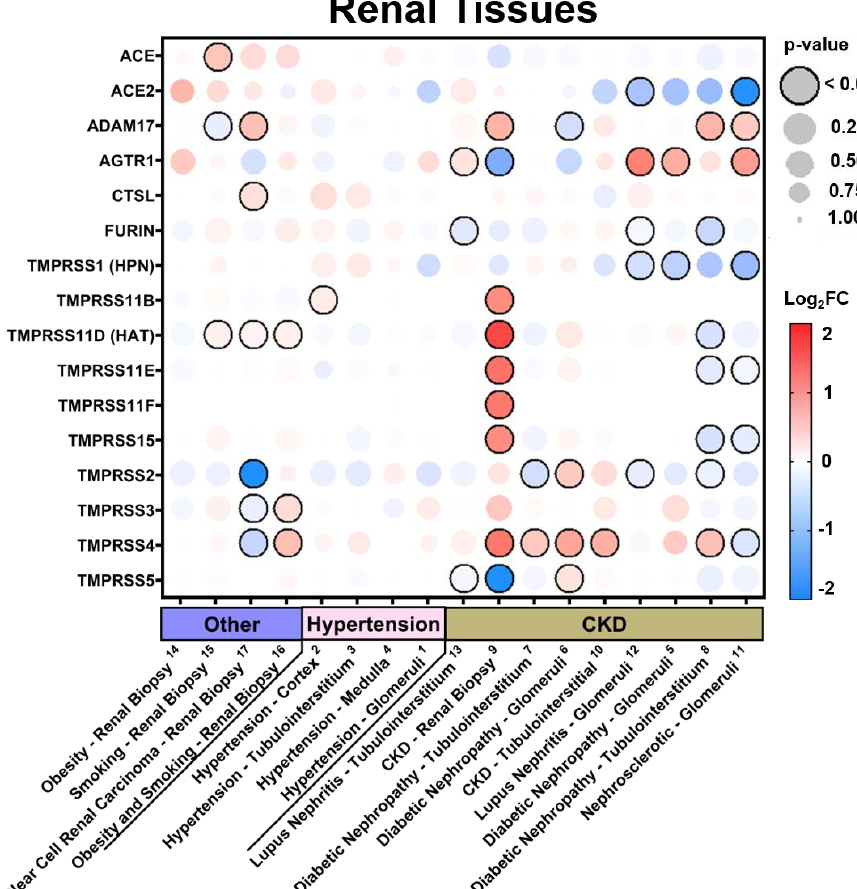
Figure 3. SARS-CoV-2 viral-entry gene expression in renal tissues across comorbidities. Expression of select SARS-CoV-2 viral-entry genes in renal tissues across 17 DataSets representing various common comorbidities. Values are displayed as logarithm to base 2 of the fold change (log2FC) in comparison with respective una ff ected control samples from each DataSet. Comorbidity groups and each DataSet within are sorted from greatest ( left ) to least ( right ) expression of ACE2. Heatmap coloration is set to a scale of − 2 (blue) to 2 (red) and values beyond this range are shown as either − 2 or 2, respectively. Statistical significance is represented proportional to dot size where largest dot size indicates highest statistical significance as indicated in the key and a black border designates p < 0.05. Superscript numbers link each DataSet to additional information found in Appendix A and Supplementary File 1. CKD = chronic kidney